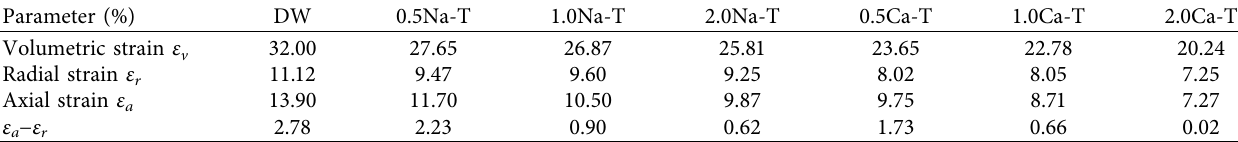
Table 5: Shrinkage strain parameters of bentonite specimens saturated with different salt